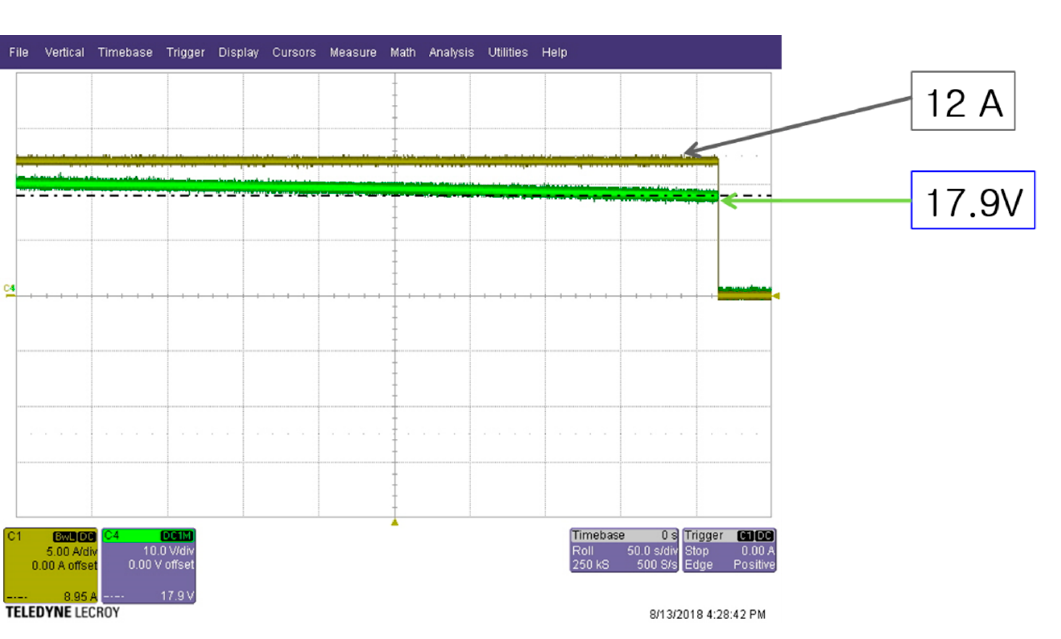
Figure 5. Test results of overcharge protection